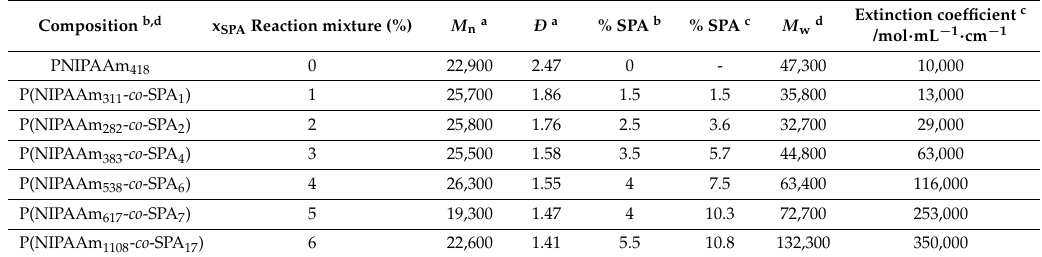
Table 1. Summary of characterization data for the synthesized P(NIPAAm- co -SPA) copolymers resulting from varying amounts of SPA in the reaction